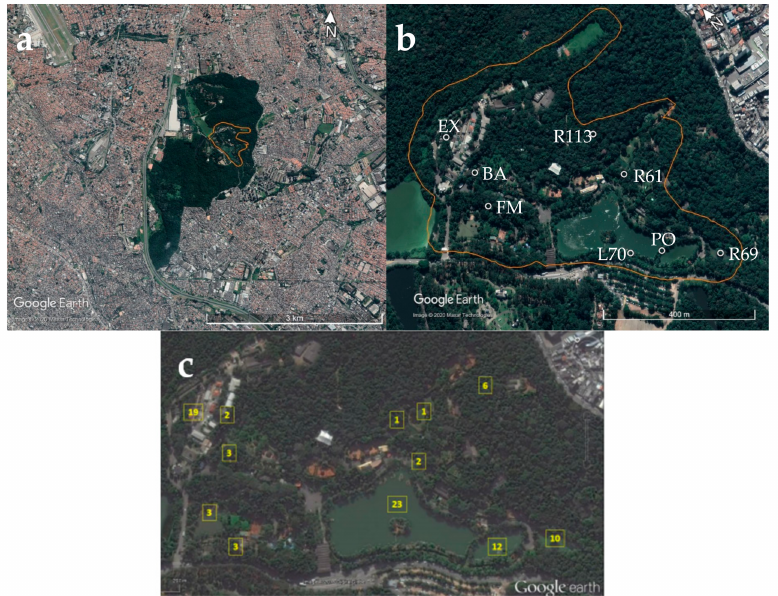
Figure 1. Location map of Parque Estadual das Fontes do Ipiranga (PEFI) in S ã o Paulo, Brazil ( a ). In zoom, S ã o Paulo Zoo and the sampling areas (white circles) ( b ) chosen considering the number of infected individuals distributed according to their probable sites of infection, after evaluation of the clinical and parasitological history of the infected birds that were analyzed in a previous study [13] ( c